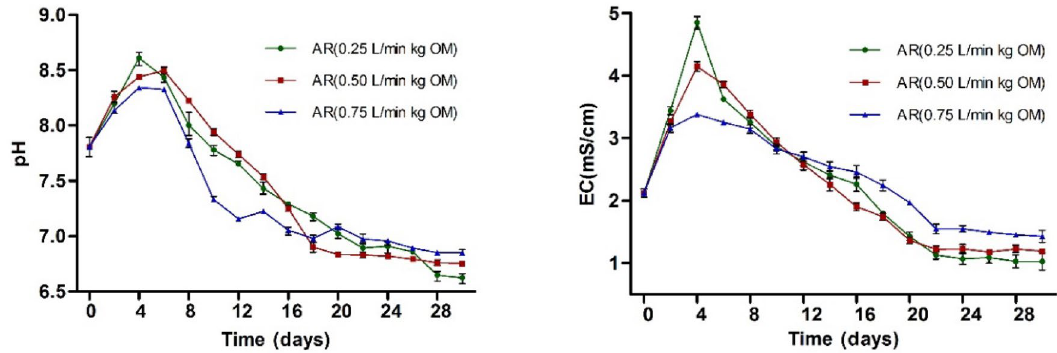
Fig. 3 Variations in pH and electrical conductivity (EC) during the composting process with three aeration